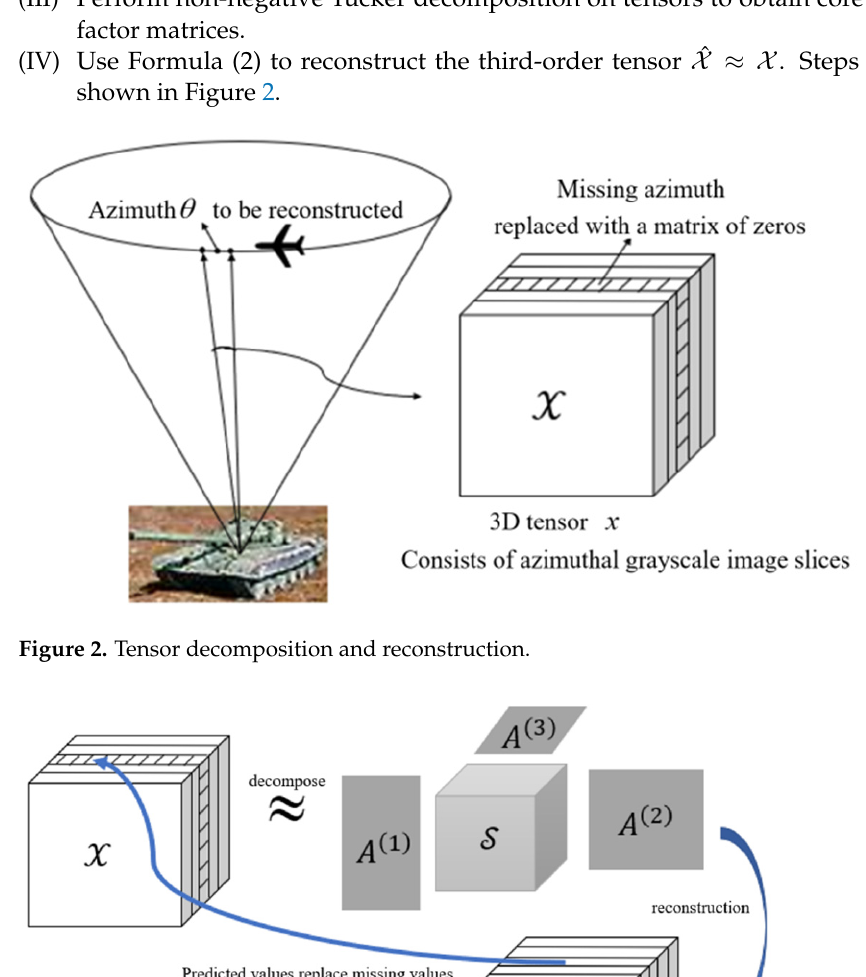
Figure 3. Tensor decomposition and reconstruction.